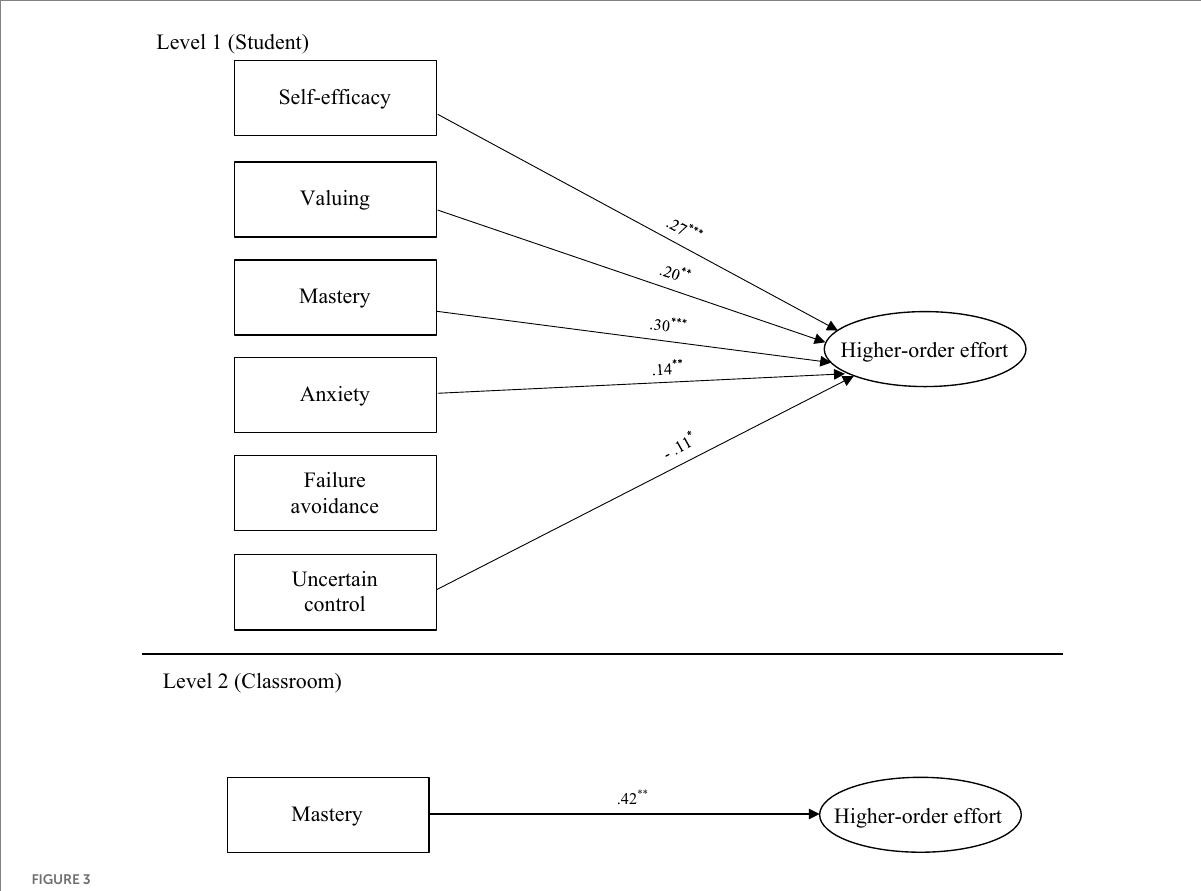
FIGURE 3 Significant substantive paths in central multilevel analysis—Higher Order Effort Factor (MSEM 2 ). Only significant paths are shown and are labeled with standardized betas ( β ); * p < 0.05. ** p < 0.01. *** p < 0.001; All paths controlled for variance attributed to covariates (Level 1: age, gender, social- economic status, non-English speaking background, and mathematics ability; Level 2: class-average ability, class size, and class-average age). See Table 3 for all covariate associations and all non-significant paths.